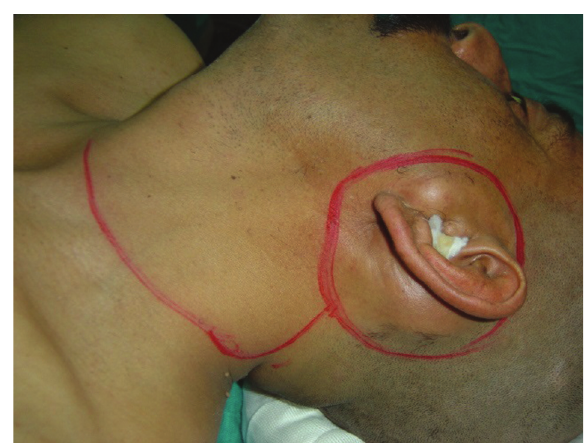
Skin marking extended to the neck in patient 1.